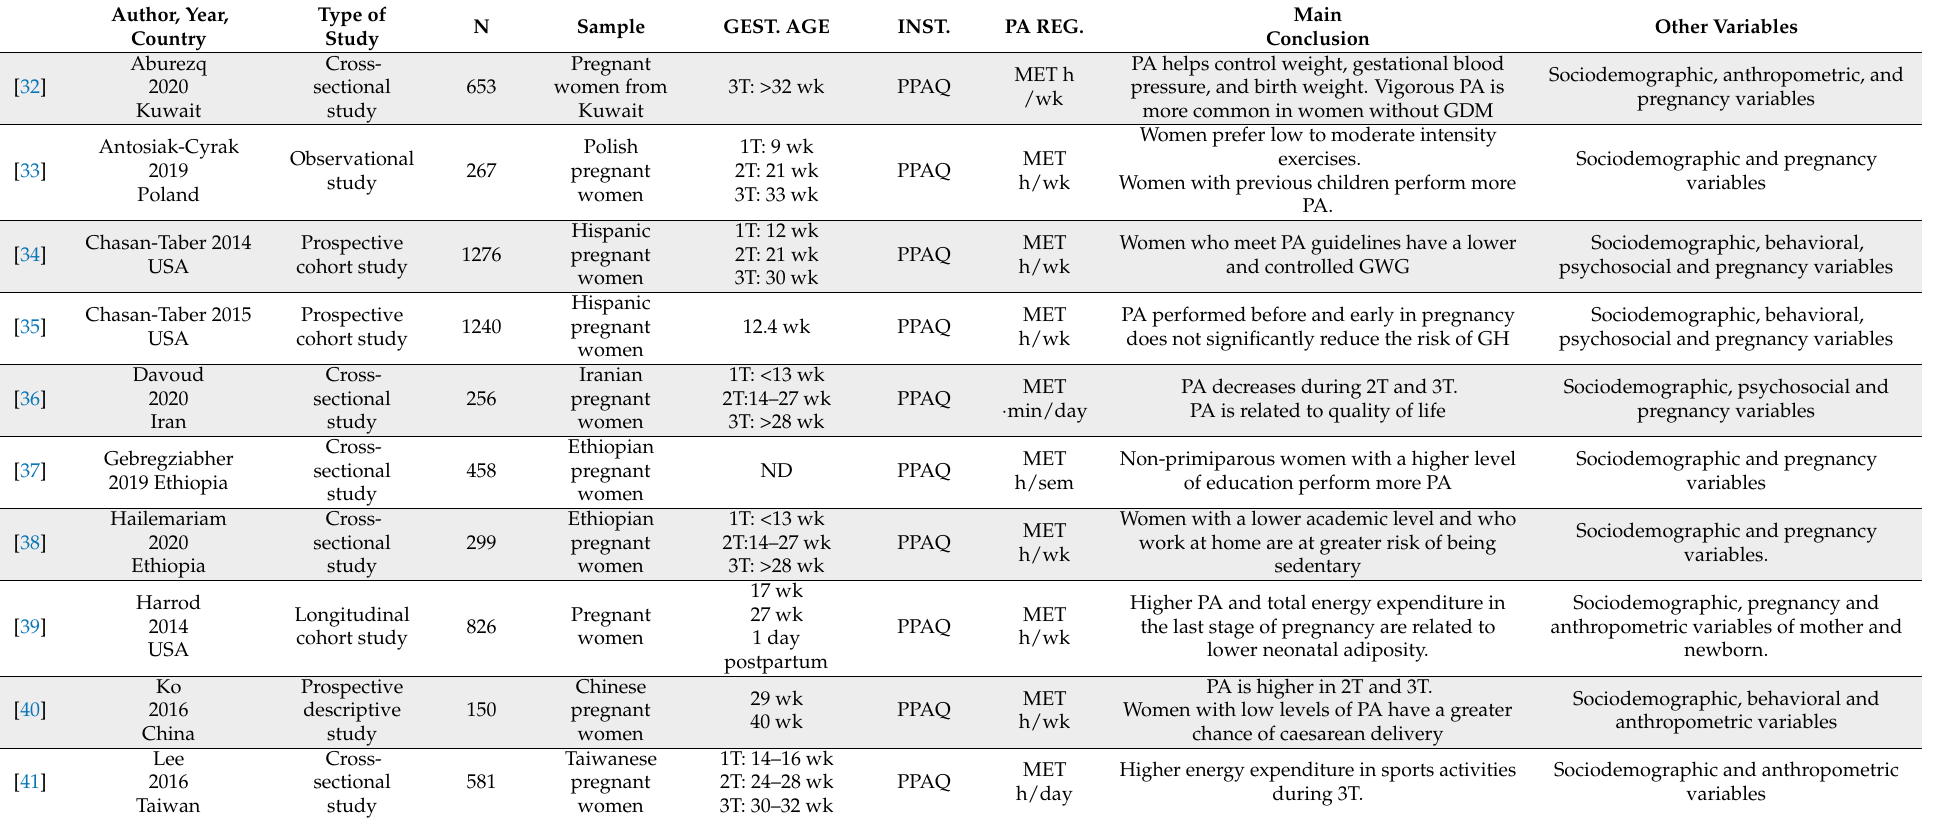
Table 3. Record of Physical Activity using the PPAQ questionnaire during